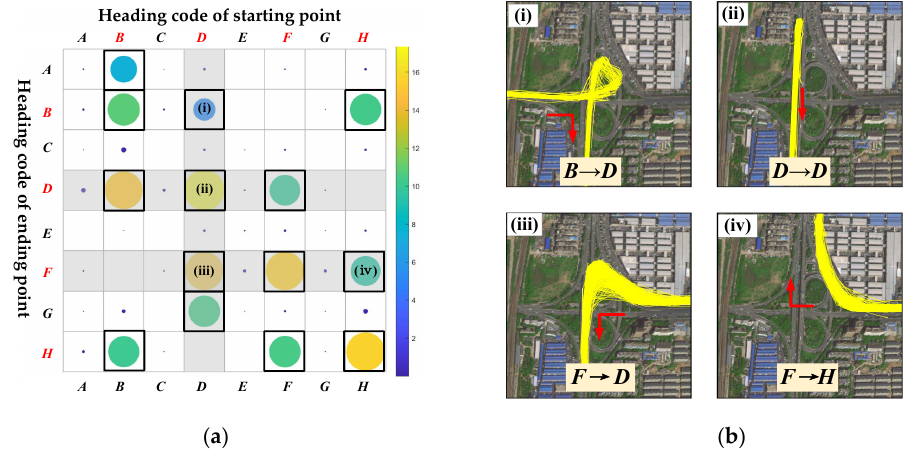
Figure 7. Turning-modes segmentation based on heading code matrix of starting and ending points: ( a ) the heading code matrix of starting and ending points and ( b ) the trajectory segments of typical turning modes.